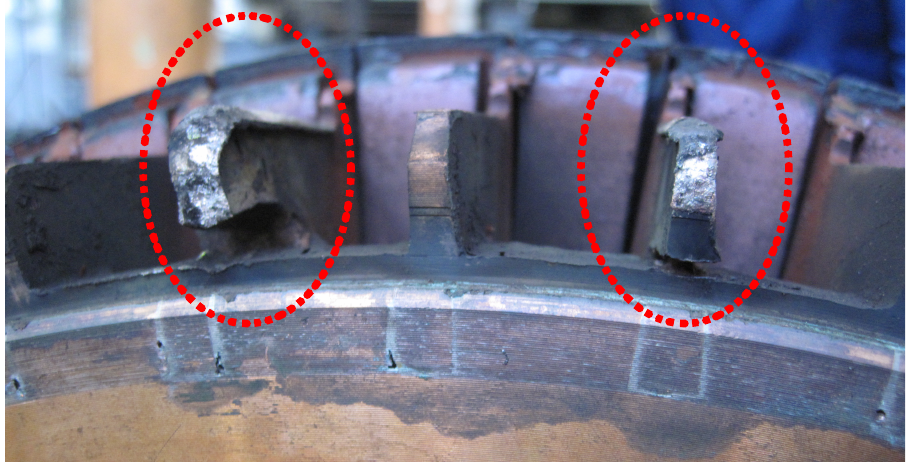
Figure 16. Rotor of an induction machine of 3.15 MW, 6 kV, with two non-consecutive broken